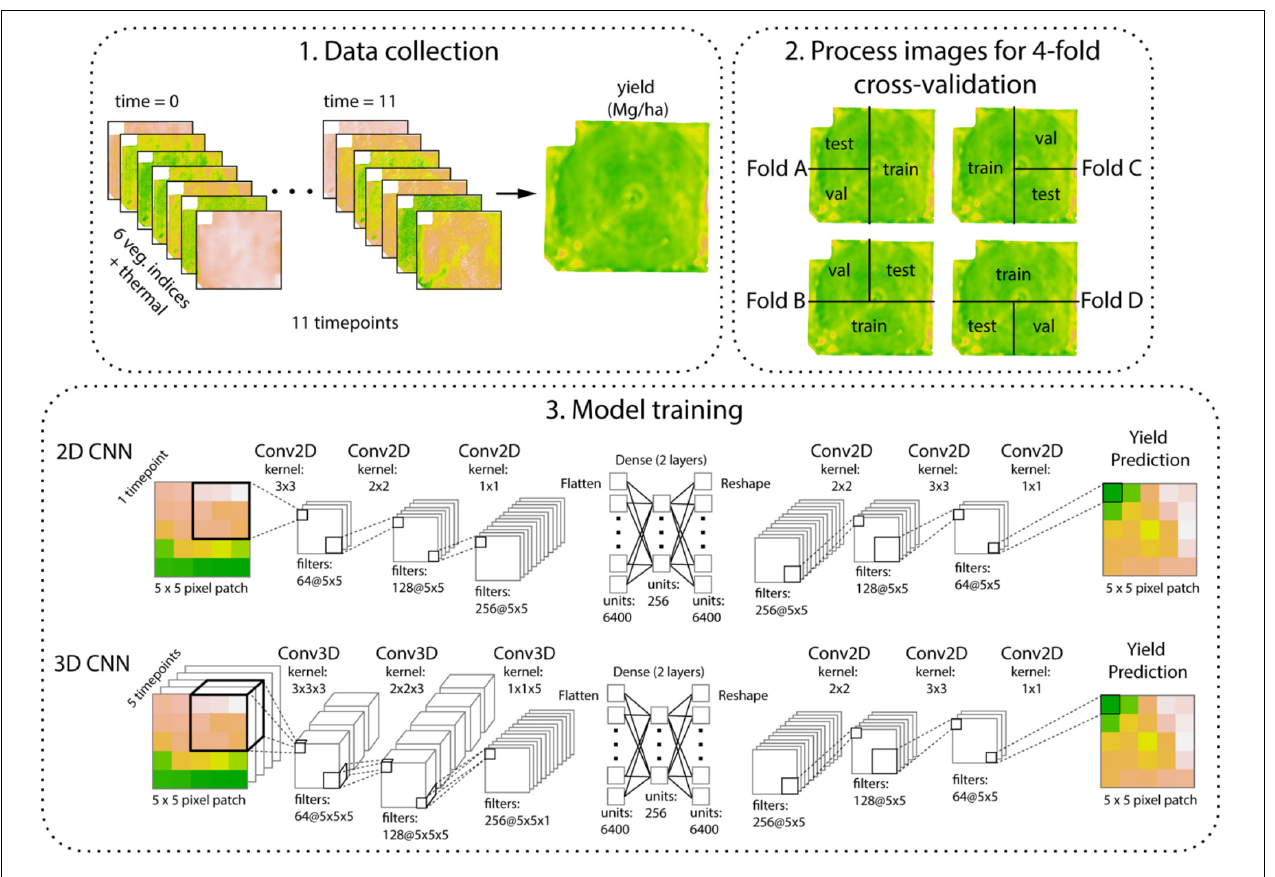
FIGURE 1 | Study design. UAV images were collected at 11 time points during the season. Predictions were based on thermal data and six vegetation indices derived from red, green, blue, red-edge, and near-infrared bands (CIgreen, GNDVI, NAVI, NDVI, RENDVI, and TGI). The field was divided into training, test, and validation images as shown for four-fold cross-validation. These larger regions were divided into 5 × 5 pixel patches (50 cm resolution pixels). Convolutional neural networks (CNNs) used an autoencoder-like structure to predict yield on an output 5 × 5 pixel patch based on 5 × 5 pixel input images, each with seven features. Model training for the 2D-CNN was based on a single time point; 3D-CNN used the five time points centered around the reproductive phase of crop